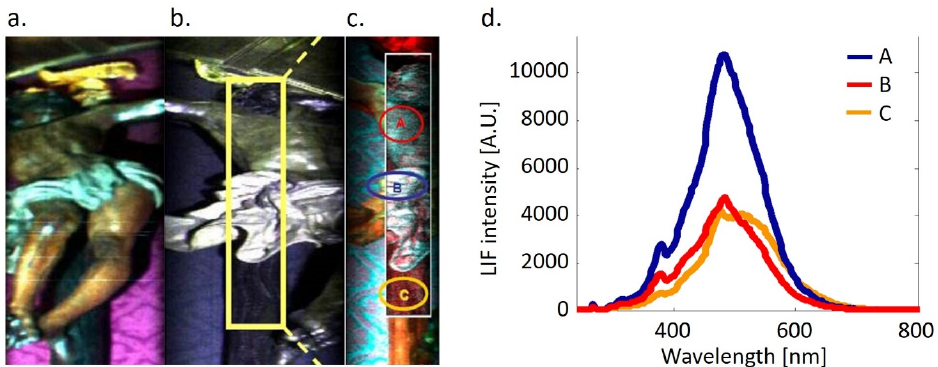
Figure 5. ( a ). Reflectance image. ( b ) LIF image with the zone for PCA study. ( c ). Zones for Spectral scanning body (A), loincloth (B), cross (C). ( d ). LIF spectra taken from di ff erent areas of the Christ body scanning body (A), loincloth (B), cross (C). ( d ). LIF spectra taken from different areas of the Christ (A), loincloth (B), cross body (A), loincloth (B), cross (C).